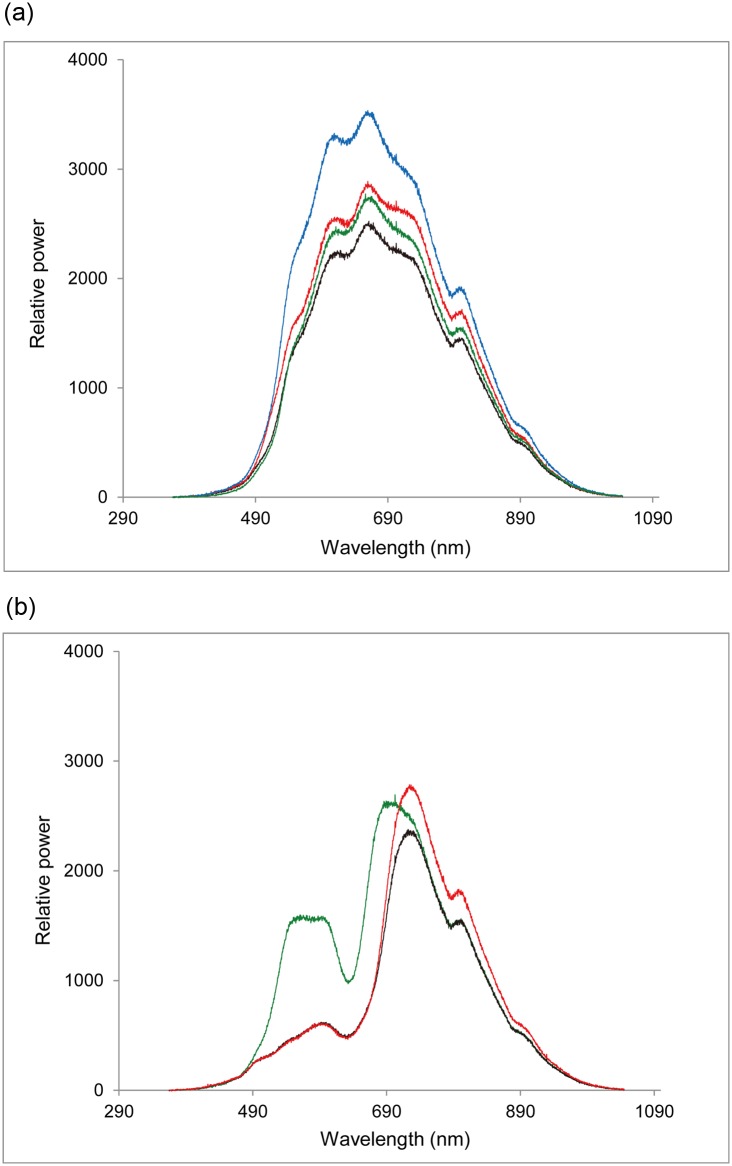
Spectra of reflected light by doughs in two-choice experiments.(a) Yellow dough with all three ingredients (black line); yellow dough without pollen (red line); yellow dough without soybean (blue line); yellow dough without sugar (green line). (b) Black doughs with all three ingredients (black line); black doughs without pollen (red line); green doughs with all three ingredients (green line).